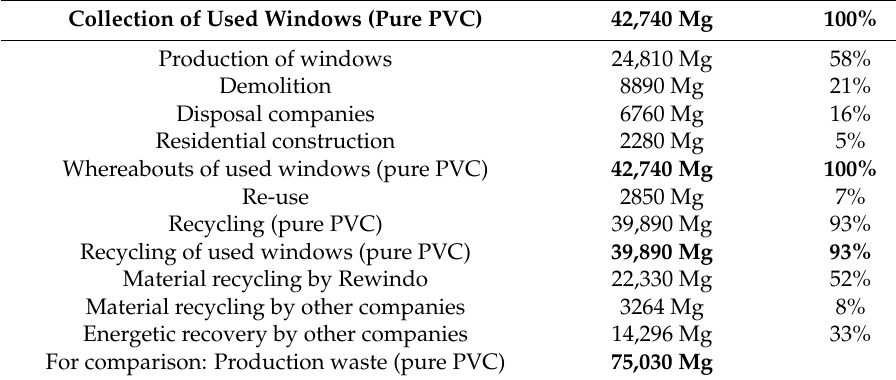
Table 3. Mass flow of used PVC windows in Germany, 2013 (Data from Rewindo [95]; bold lines contain the reference values for the respective rows